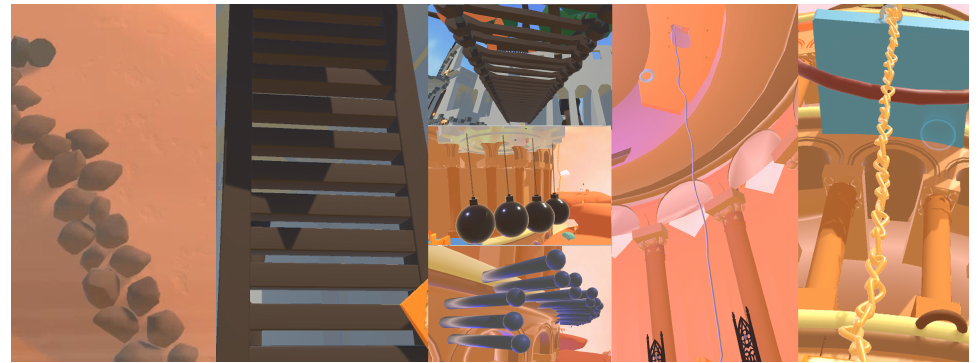
Figure 4. Climbing paths of rocks, ladders, iron ball paths, ropes, and iron chains. Rocks, iron, wood, ropes, iron chains, iron balls, and other climbing objects are set in the climbing scene. By simulating different sounds and vibration feedback for rocks, iron, wood, ropes, iron chains, and iron balls, the motion simulation is more realistic and